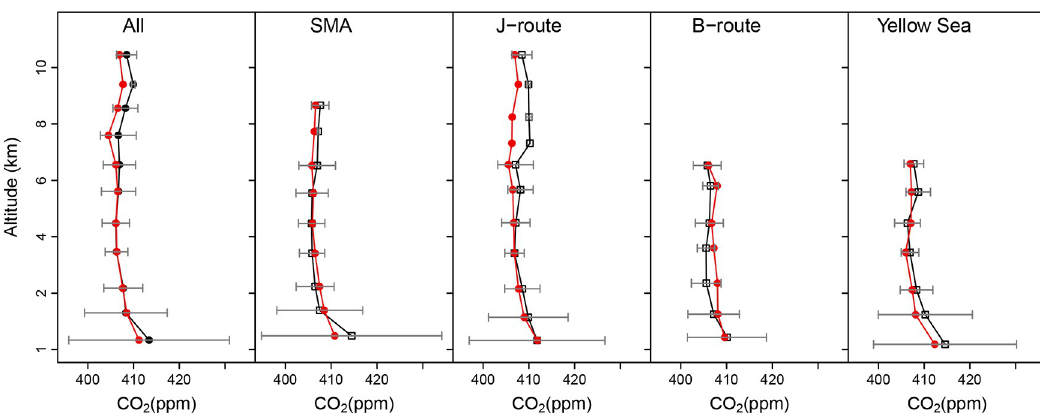
Fig 7. Vertical profile of CO 2 concentrations for each section, including SMA, J- and B-route and the West Sea as well as all flights during the study period. Red and black dot-lines indicate WRF-VPRM results and NASA DC-8 aircraft observations,